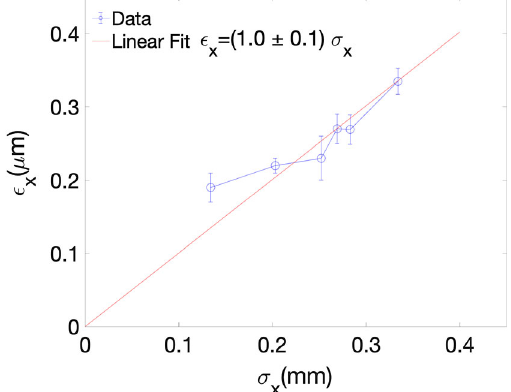
FIG. 10. Measured horizontal normalized emittance versus the rms laser spot size for low-charge bunches.